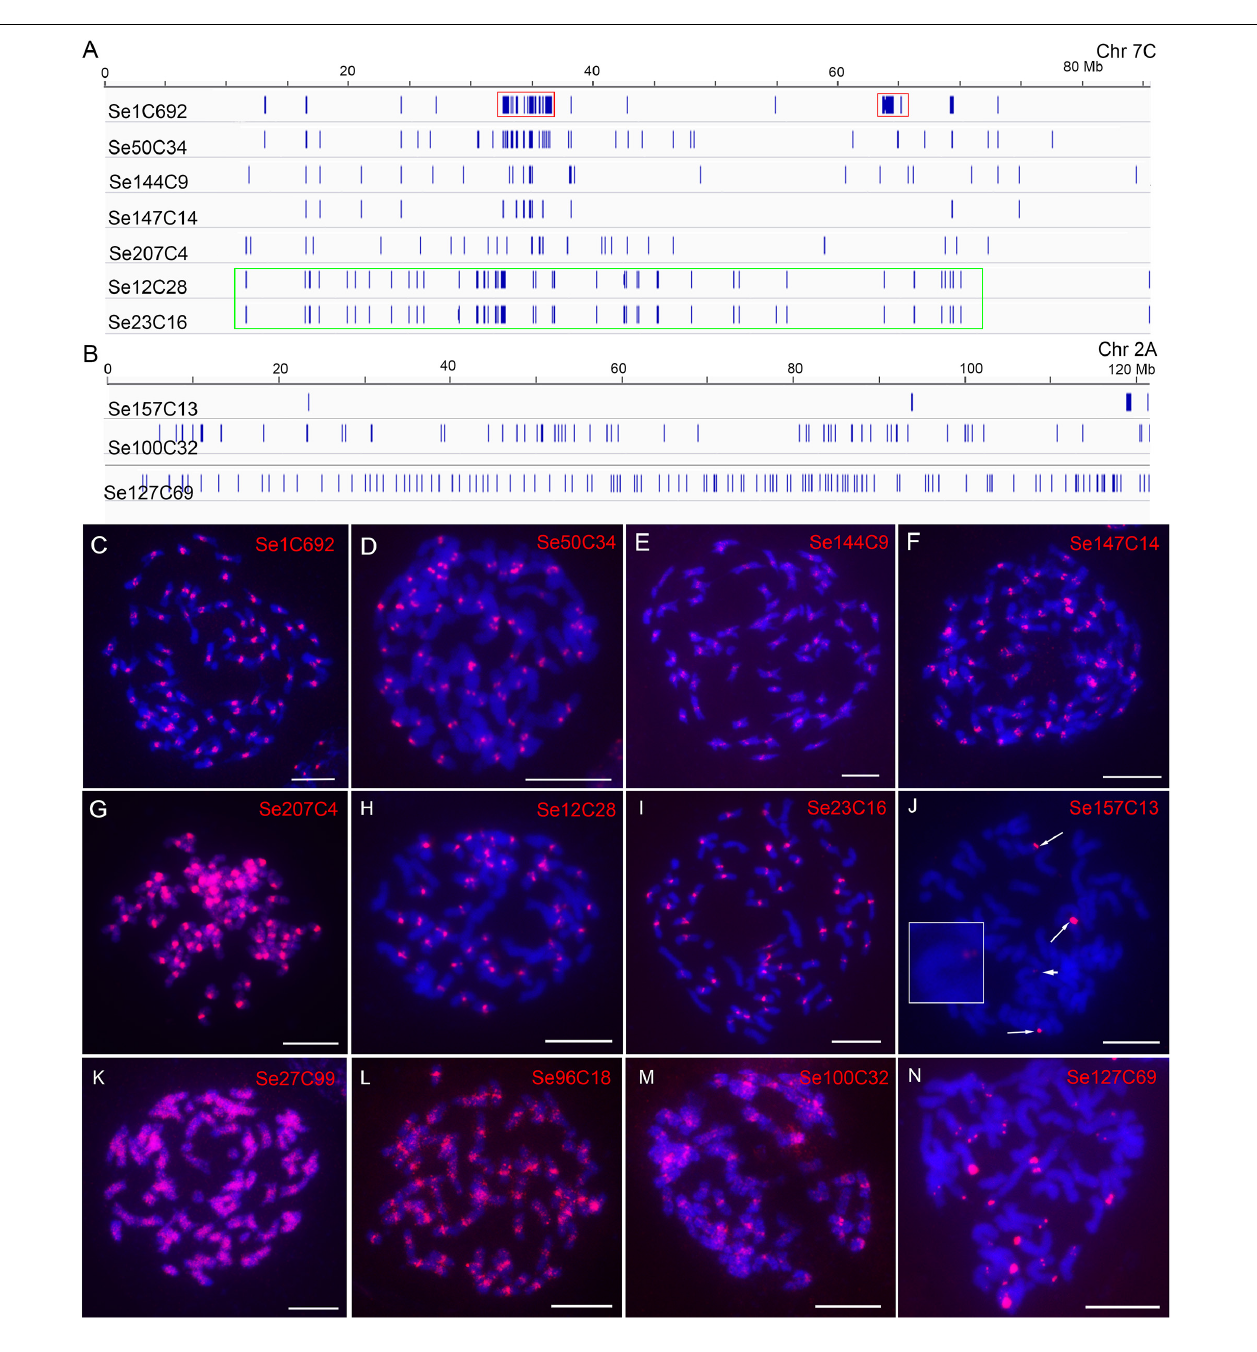
FIGURE 3 | Characterization of genomic distributions of representative repeats in SES208. (A,B) Diagrams illustrate the distributions of ten repeats in assembled pseudochromosomes. Red boxes indicate the two separated regions enriched with the copy of repeat Se1C692. The green box indicates the copy enrichment regions of Se12C28 and Se23C16 on chromosome 2A. (C–N) FISH analyses of 12 representative repeats in SES208. The four FISH signals from probe Se157C13 are indicated by arrows and arrowheads (J) . The chromosome with a weak Se157C13 FISH signal (arrowhead) was enlarged. Bars = 10 µ